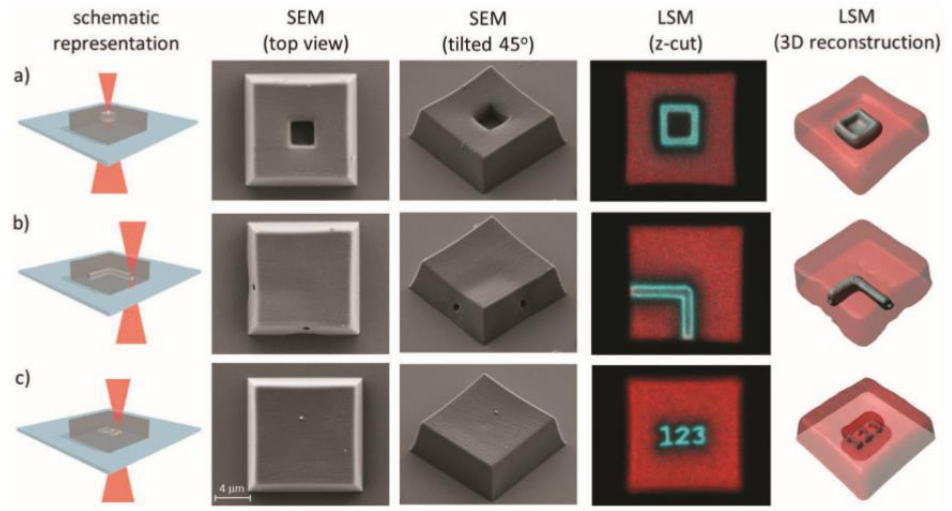
Figure 6. Laser erasing schematic procedure and SEM pictures of the printed micrometric (15 × 15 × 5 µm 3 ) blocks using a 700 nm femtosecond laser. ( a ) 3 ×3 × 3 µm 3 block, ( b ) 90° 1 µm diameter tunnel, and ( c ) simple text “123” (Reprinted with the permission from reference